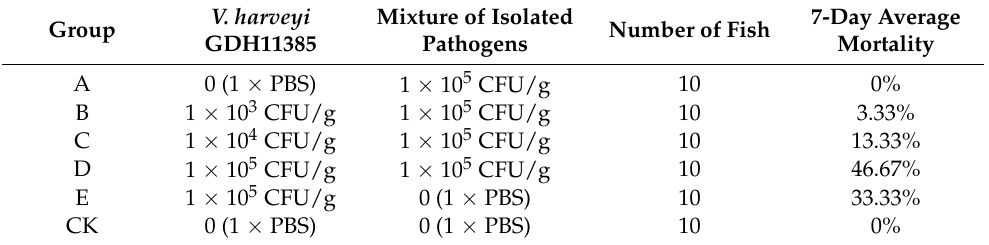
Figure 1. Dendrogram of isolated pathogens from liver samples of the diseased hybrid groupers based on ERIC-PCR analysis. Table 2. The mortality of hybrid groupers at different challenge concentrations ( n = Table 1. 16S rRNA gene sequencing and alignment results of strains isolated from the livers of dis- eased hybrid groupers.